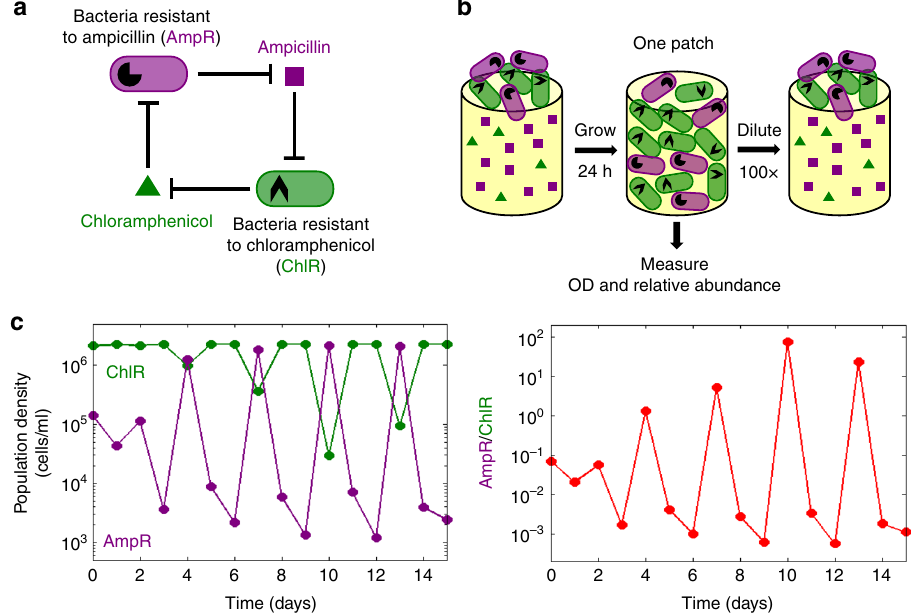
Fig. 2 A bacterial cross-protection mutualism serves as a model system to study migration-induced synchronization of population oscillations. a Diagram depicting the mutualistic interaction between ampicillin resistant (AmpR) and chloramphenicol-resistant (ChlR) cells. AmpR cells protect ChlR cells by enzymatically deactivating ampicillin, whereas ChlR cells protect AmpR cells by deactivating chloramphenicol. b Schematic illustration of the experimental growth-dilution scheme for growing isolated co-cultures in the absence of migration. Each day, cells are grown for 24 h and then diluted by a factor of 100 into fresh media and antibiotics. The total cell density as well as relative proportions of AmpR and ChlR cells are measured after 24 h of growth, before the dilution step. c Isolated co-cultures exhibit period-3 oscillations in the density of AmpR and ChlR cells (left panel) as well as in the ratio of AmpR cells to ChlR cells (right panel) under benign conditions. This experimental condition corresponds to 10 μ g/ml of ampicillin and 8 μ g/ml of